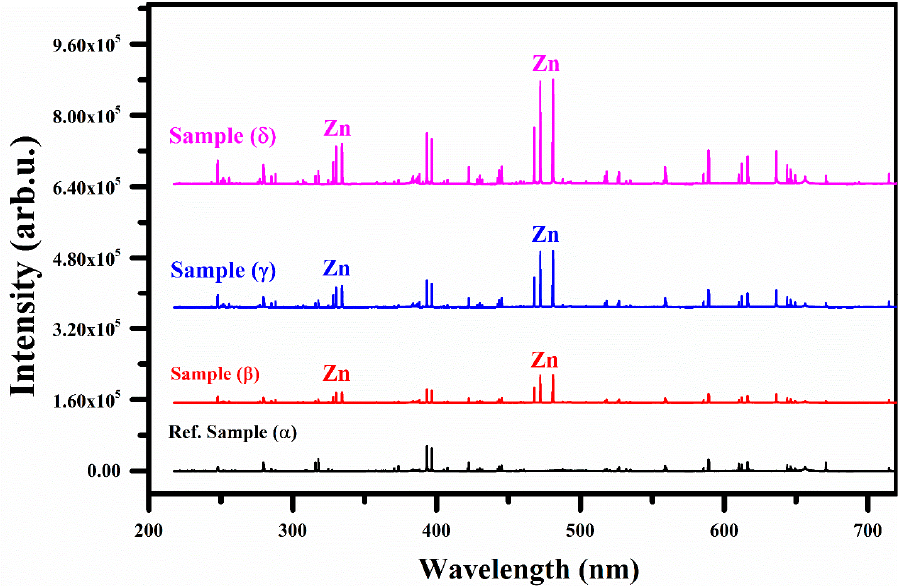
Figure 6. Average LIBS spectrum of the 3 doped P. harmala samples-( β , γ , and Δ ) and one reference un-doped sample-( α ).